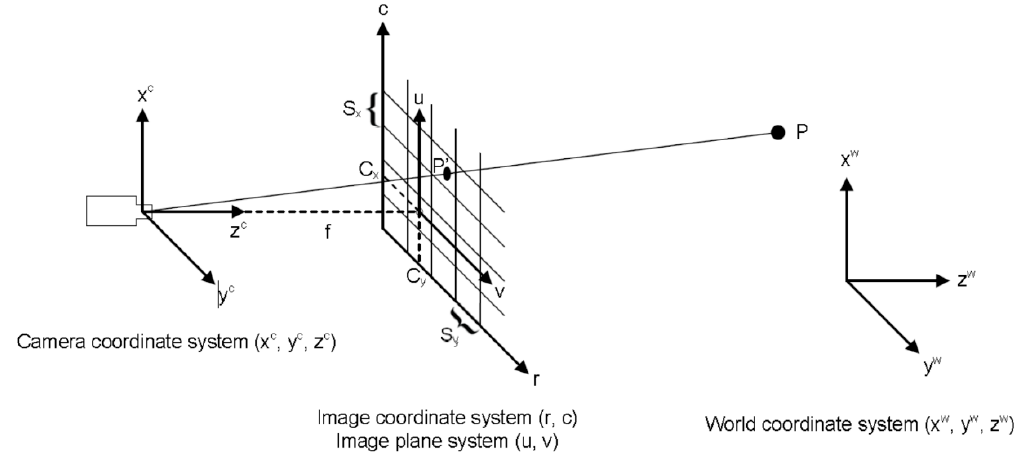
Figure 1. Pinhole camera model [23].